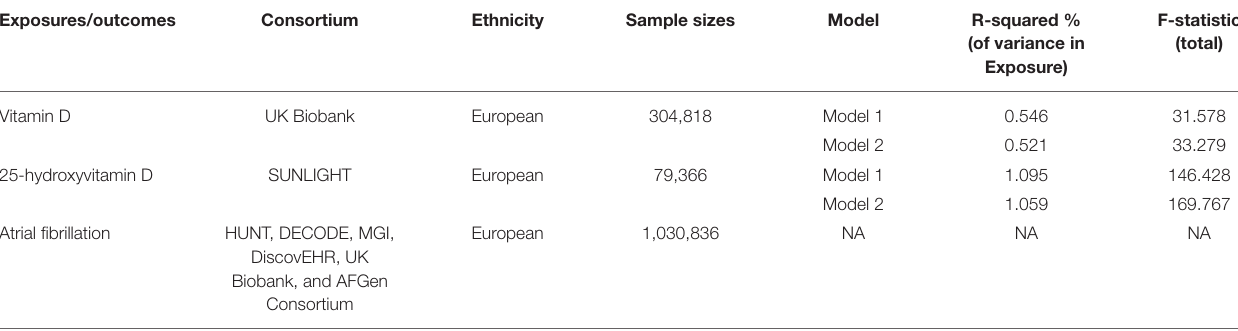
TABLE 1 | Details of studies included and predictive strength of IVs in Mendelian randomization analyses (two-sided α = 0.05). Exposures/outcomes